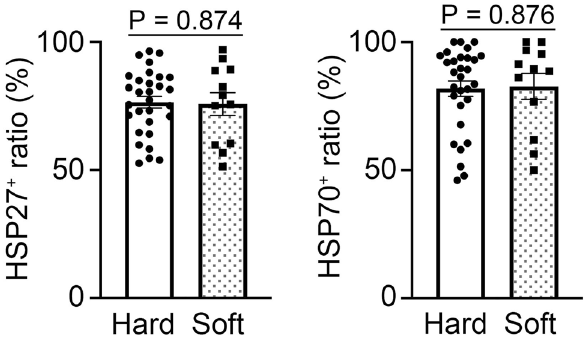
Figure 3. The frequency of appearance of HSP27 and 70 in hard and soft ligatures. Hard, n = 30; soft, n = 12. The ratio of HSP27 positives and HSP70 positives in the corresponding keratinocytes in the skin